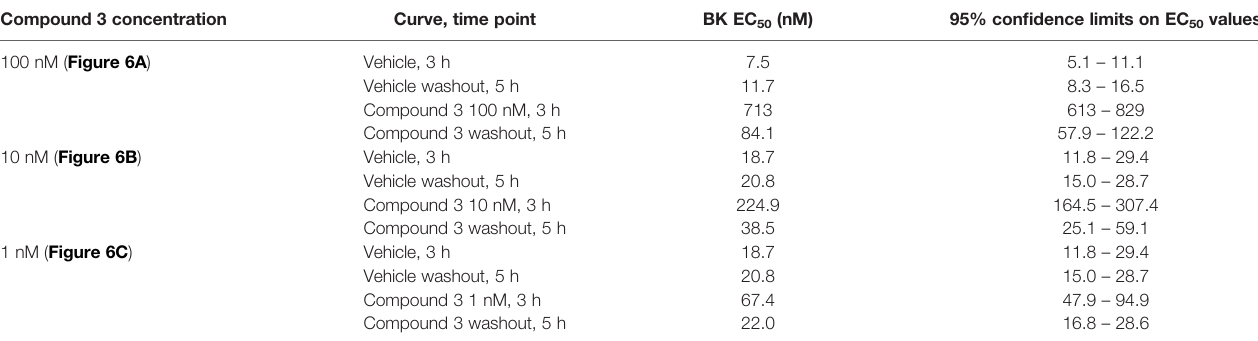
TABLE 6 | Apparent BK EC 50 values in the Compound 3 reversibility experiment ( Figures 6A – C ).